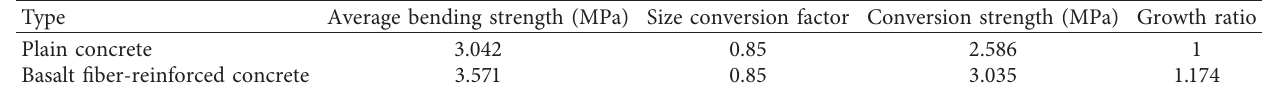
Table 3: Test results of flexural